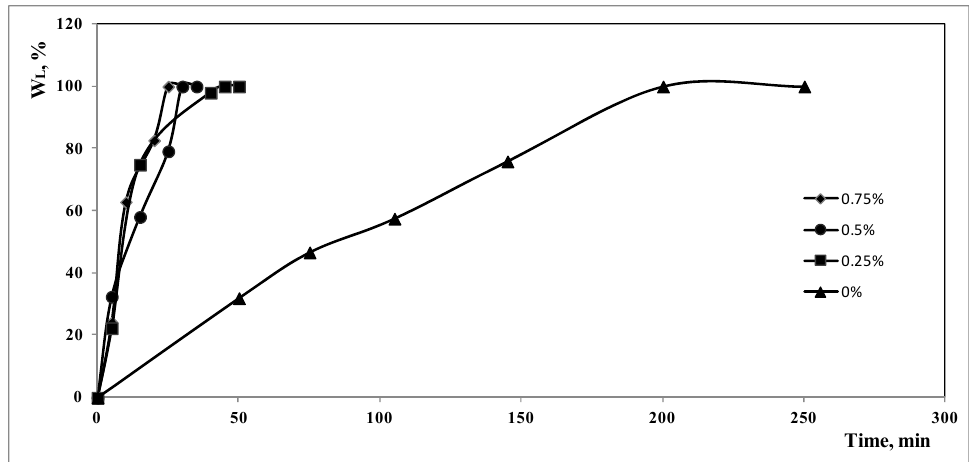
Figure 1. Percentage weight loss during the ultrasonic treatment at T= 30 °C, at the maximum power of the ultrasonic bath and at different ammonia concentrations.